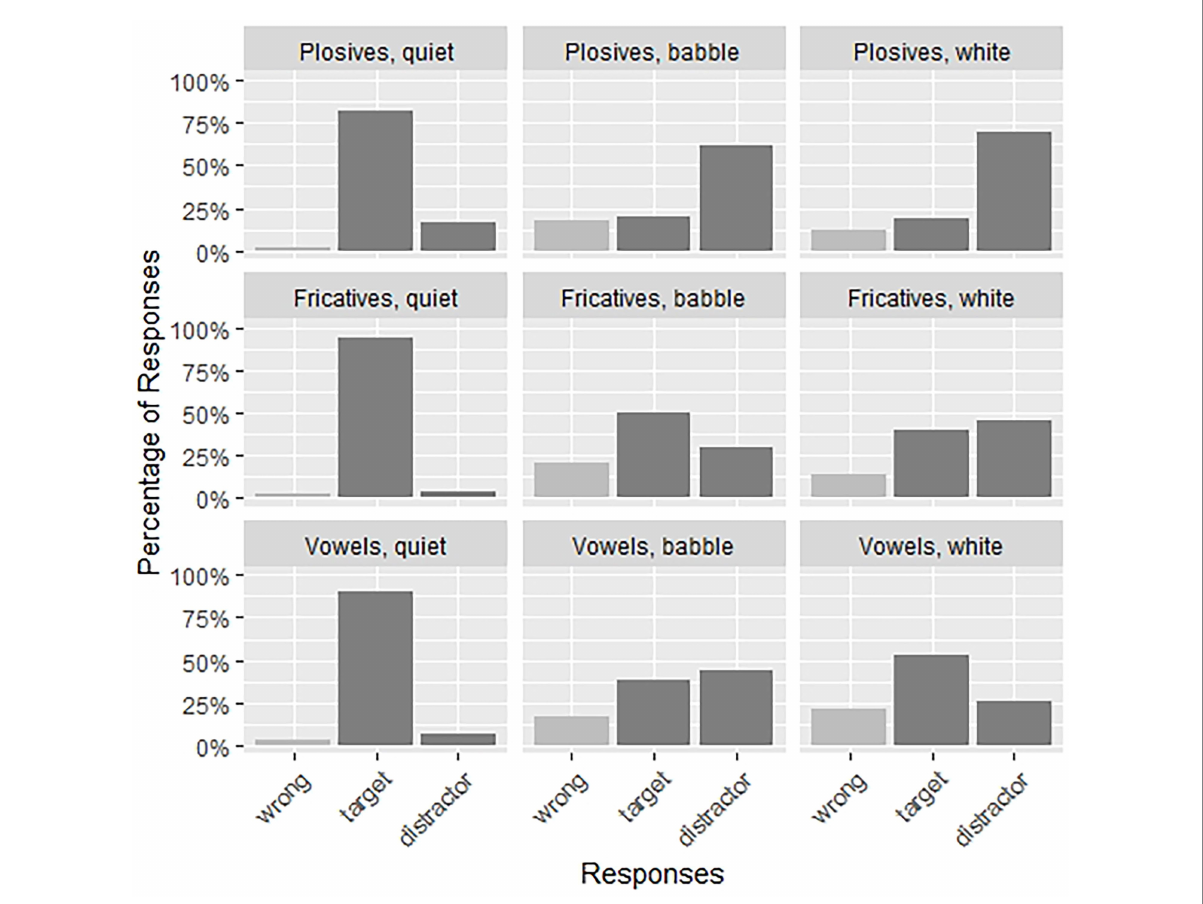
FIGURE 3 The proportion of participants’ responses (wrong, target, and distractor) for each of the three noise conditions (quiet, babble, white noise) and three sound types (plosives, fricatives, vowels) for the low predictability condition.